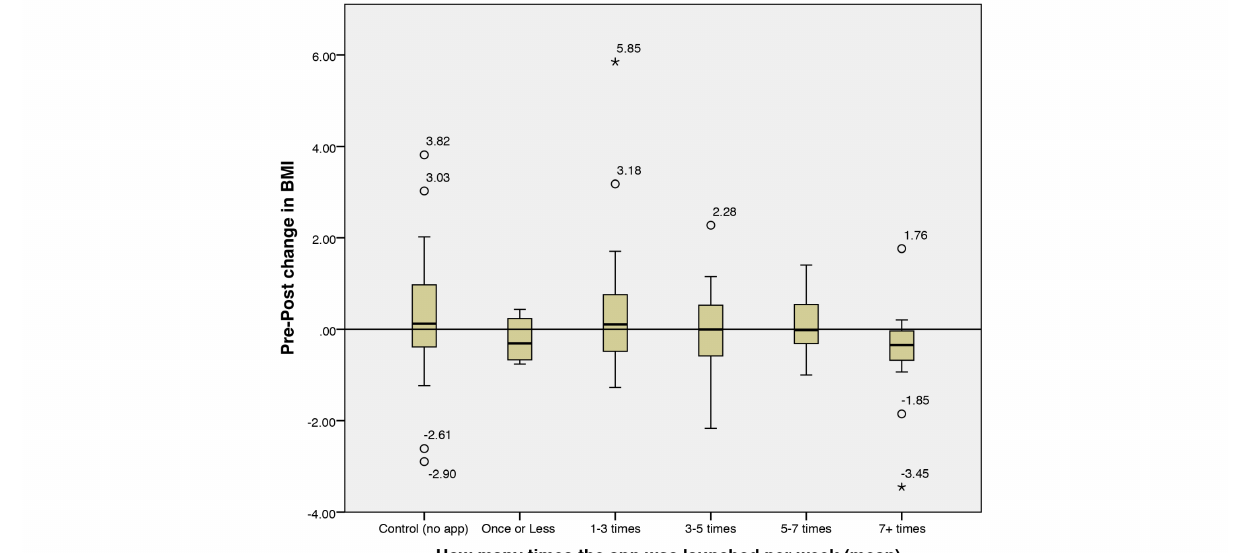
Figure 8. Boxplot showing no app (control) and grouped app launches per week (treatment) against observed changes in body mass index (BMI). Outliers are plotted as individual